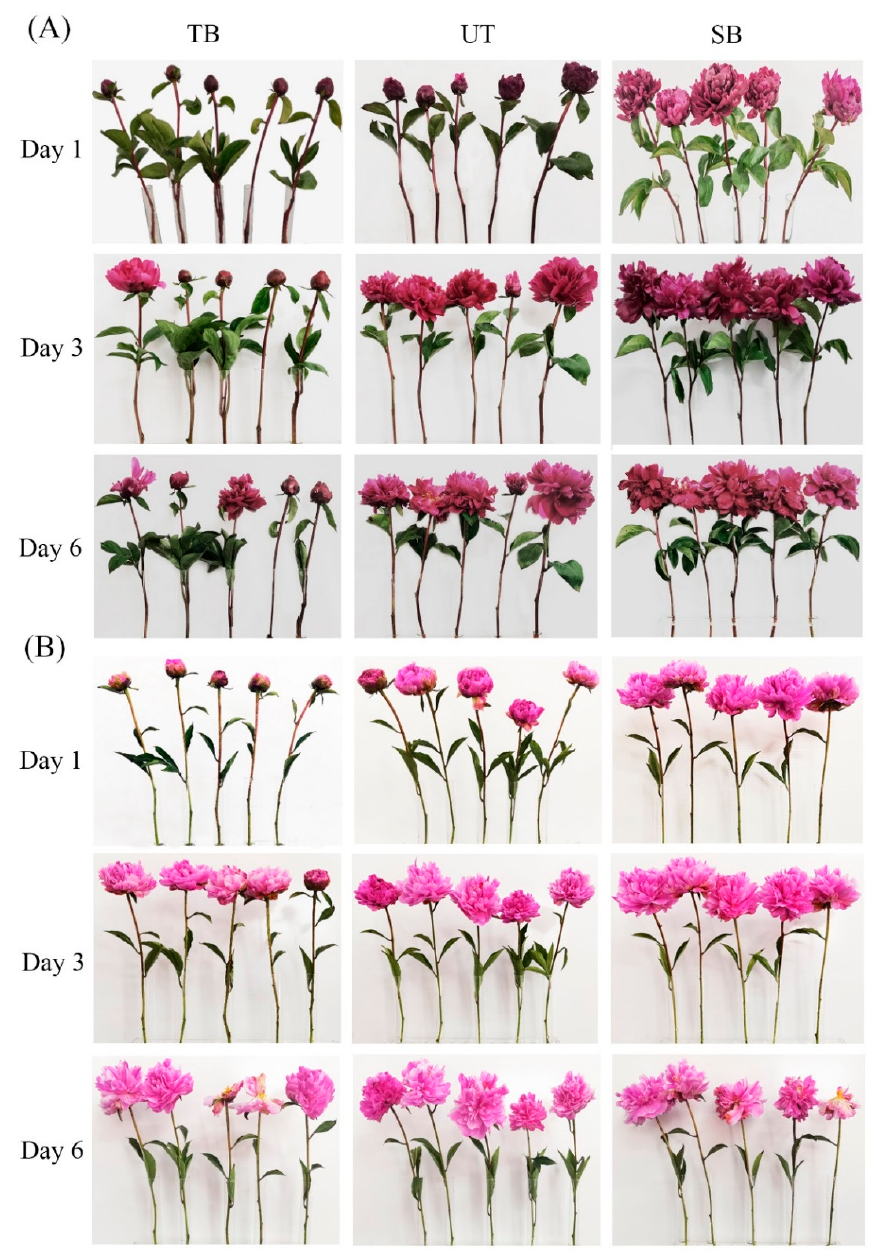
Figure 1. Flowering morphological of different harvest stages of “open-top type” cut P. lactiflora. ( A ) The appearance of flowering changes of ‘Dan Feng’ in three harvesting stages on the first, third, and sixth vase day. ( B ) The appearance of flowering morphology changes of ‘Lu Xihong’ in three harvesting stages on the first, third and sixth vase